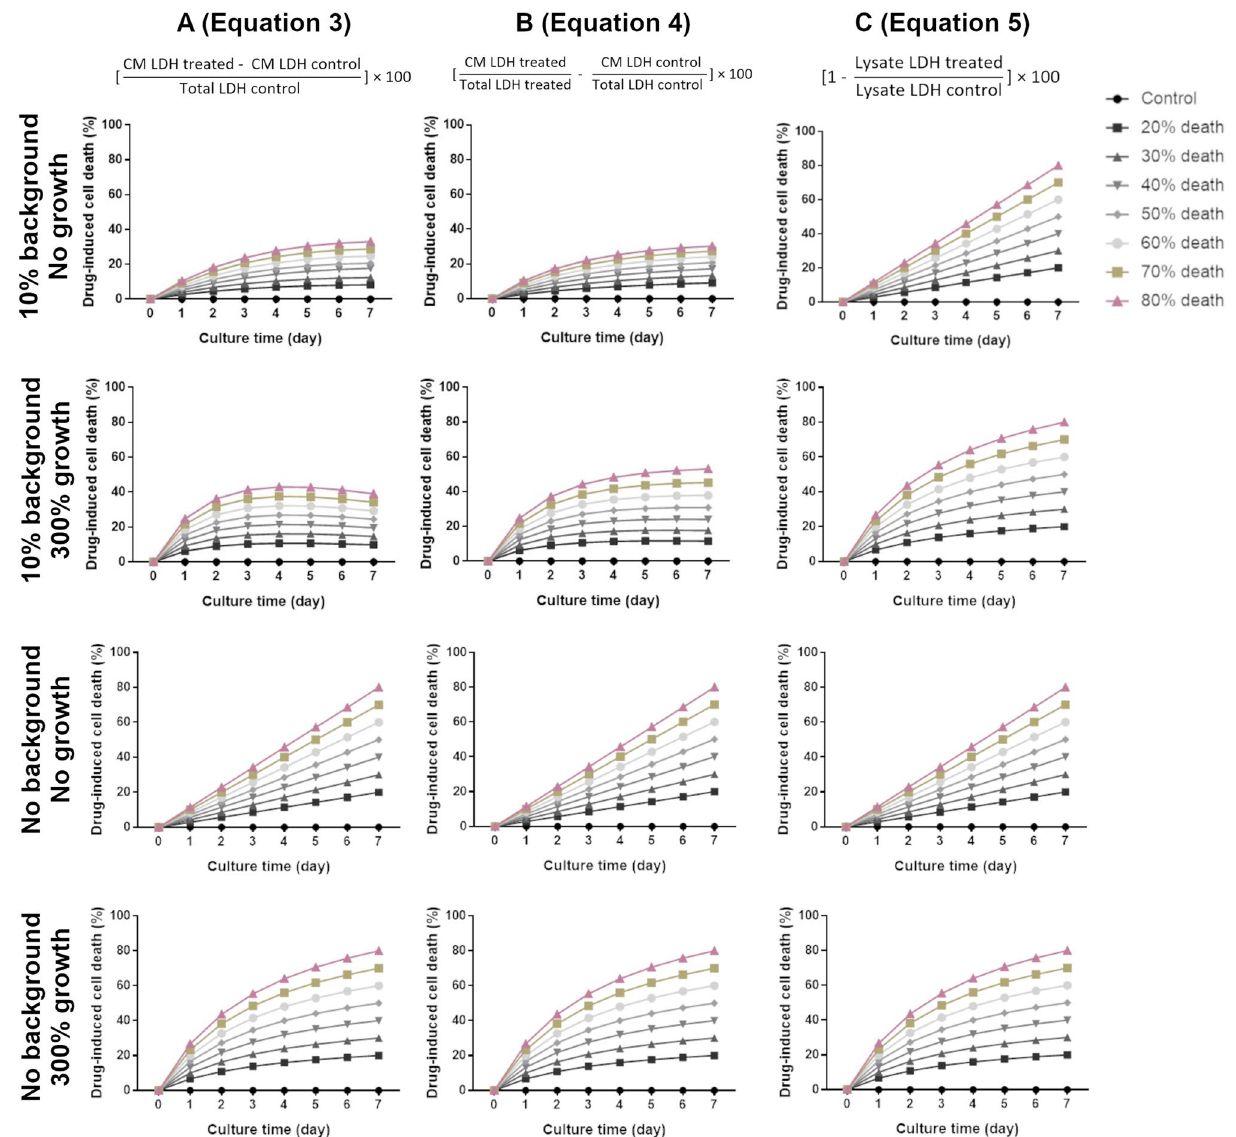
Figure 2. Culture growth dynamics impact how LDH data should be analyzed to evaluate therapeutic efficacy. Simulations represent cases in which a therapy that induces 0–80% cell death over the 7-day culture period has been applied to cultures that have 10% or no background LDH and do not grow or cell number triples over the culture period. Drug-induced cell death was calculated employing Eq. (3) ( A ), Eq. (4) ( B ) or Eq. (5) ( C